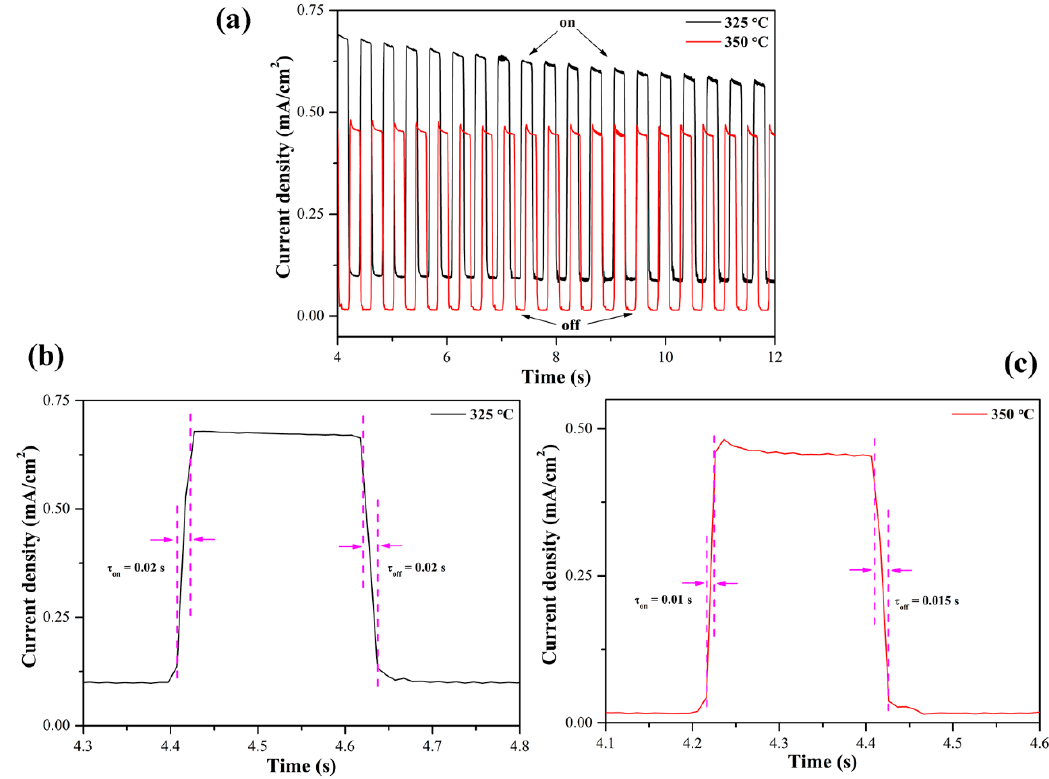
Figure 7. ( a ) Time-resolved PEC photoresponse of Te-Sb 2 Se 3 films annealed at 325 and 350 °C. ( b ) and ( c ) show the response and recovery times, respectively.